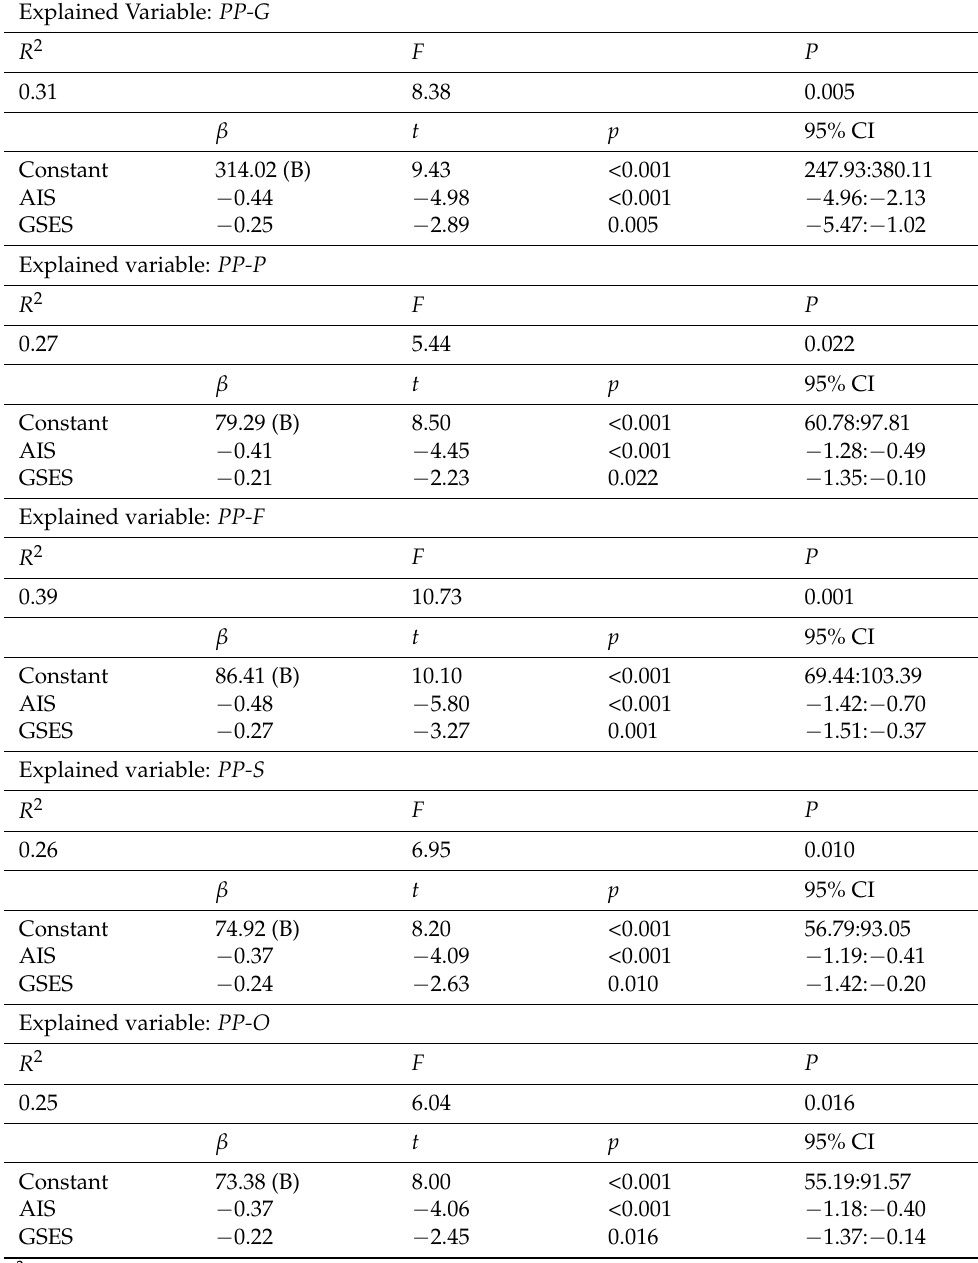
Table 5. Predictors of psychosocial problems—the UE